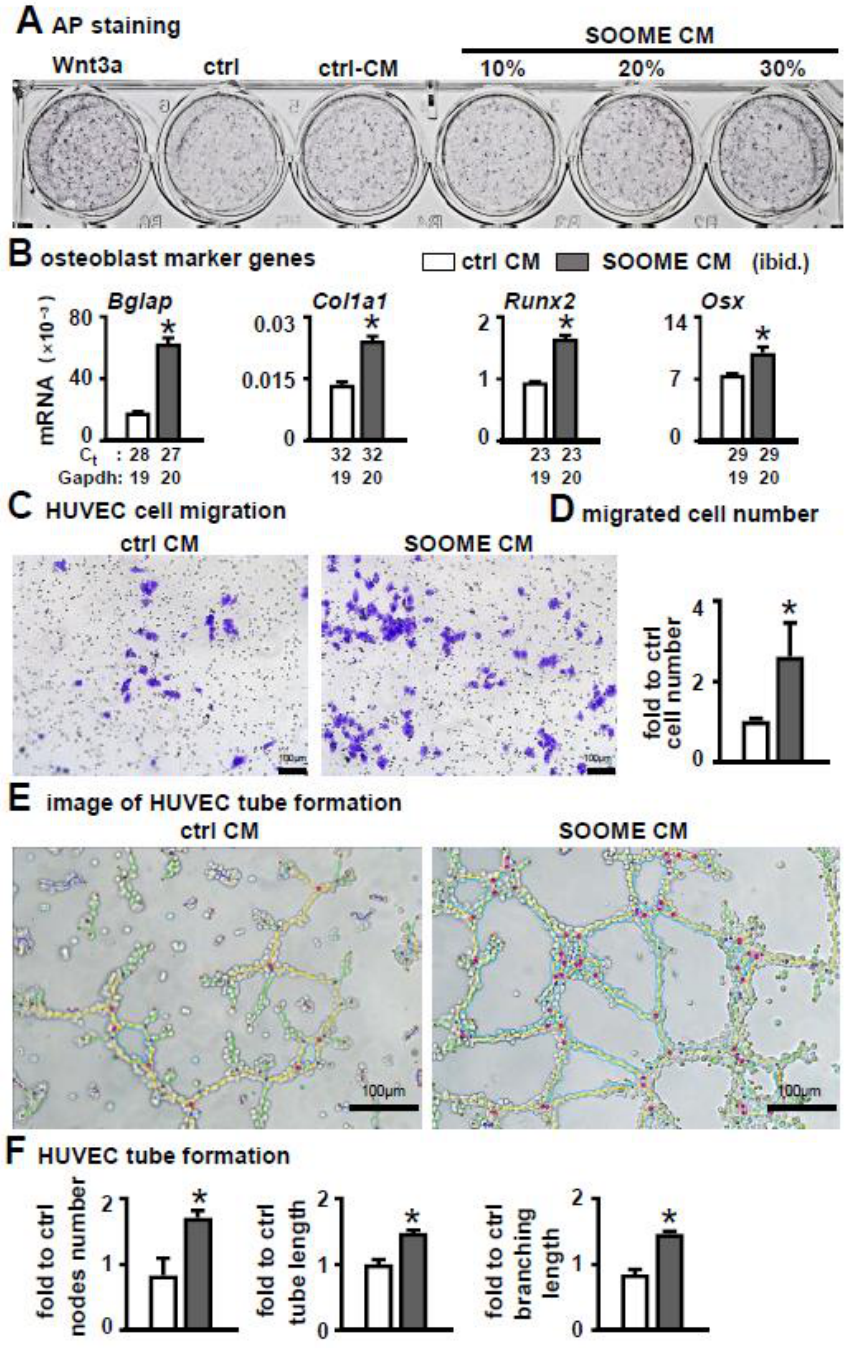
Figure 7. Effects of conditioned medium of SOOME on osteoblast differentiation and angiogenesis. The conditioned medium was collected from the supernatant of the medium of 24 h culture of SOOME and control CM. ( A , B ) Effect of conditioned medium on osteoblast differentiation of ST2. Osteoblast differentiation assays for ( A ) AP staining and ( B ) qPCR detection of the expression of osteoblast marker genes with or without conditioned medium. ( C – F ) Effects of conditioned medium on angiogenesis. Endothelial cell migration assay: imaging ( C ) and quantification ( D ) of migrated cells cultured in the transwell chamber with conditioned medium for 48 h; Imaging ( E ) and quantification of and node formation ( F ) of HUVEC cells cultured on Matrigel with conditioned medium. The * symbol indicates p < 0.05 versus control conditioned medium by t -test; n = 3. Scale bar = 100 µ m. Green = branches; orange = master segments; blue sky = meshes; red surrounded by blue = nodes; Ct, cycle number detected by qPCR machine for a relative amount of target genes.